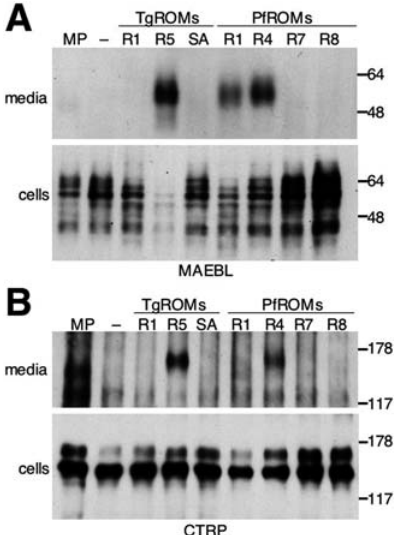
Figure 8. Cleavage of MAEBL and CTRP Adhesins, Which Are Required for Invasion of Mosquito Cells, by Parasite Rhomboid Enzymes GFP-tagged MAEBL (A) and CTRP (B) were cotransfected with each rhomboid, and conditioned media were analyzed by anti-GFP Western. Molecular weight standards in kDa are denoted to the right of each